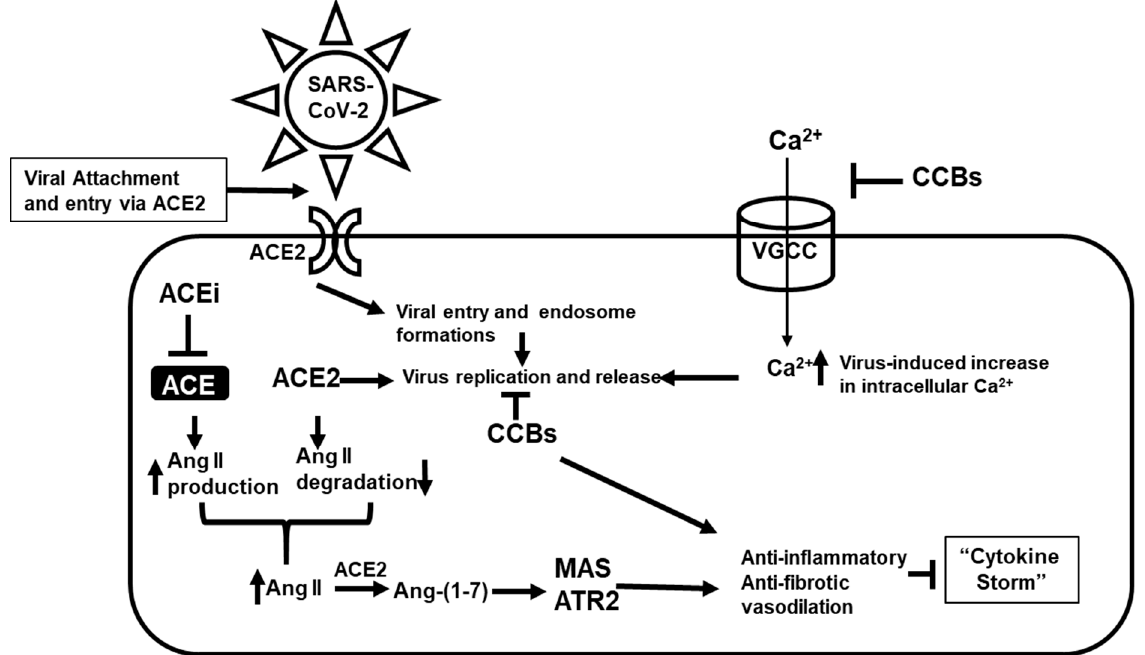
Figure 1. Potential model for the combinatorial actions of angiotensin-converting enzyme inhibitors (ACEi) and calcium channel blockers (CCBs) on SARS-CoV-2 infection, replication, and proinflammatory response. ACEi acting indirectly through ACE2 and the mitochondrial assembly 1 (MAS), ATR2 axis imparts an anti-inflammatory and anti-fibrotic response, while CCBs acts at various steps, restores intracellular Ca 2+ flux, consequently inhibiting post-infection virus internalization and genome replication. Both ACEi and CCBs potentially can induce a synergistic anti-inflammatory and anti-fibrotic response in the attenuation of the “cytokine storm”.